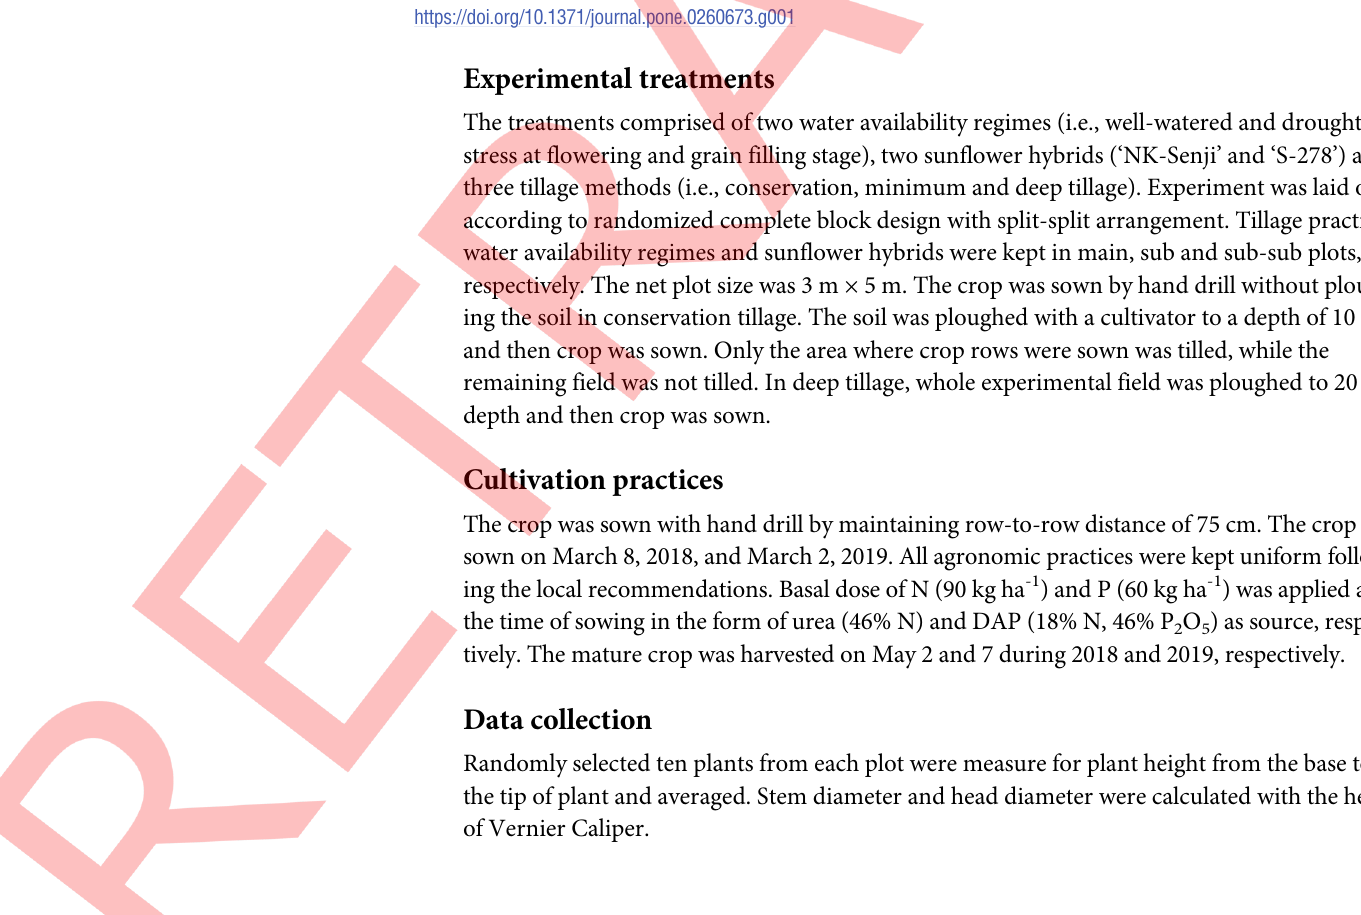
Fig 1. Average maximum and minimum temperature and rainfall during sunflower growth period during 2018 and